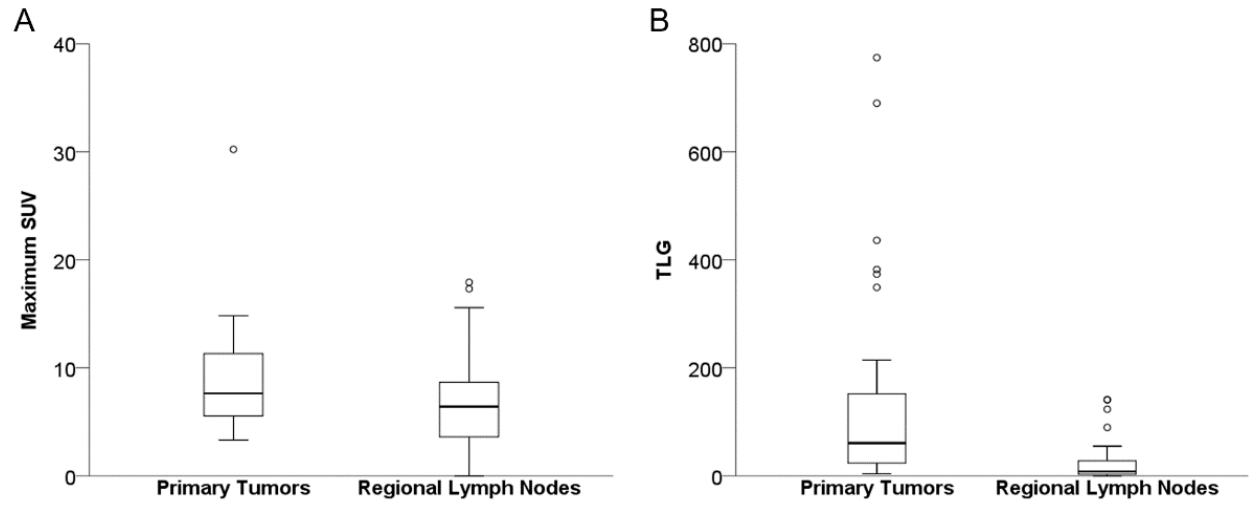
Figure 3. Box plot of 18 F-FDG uptake of primary tumors and regional lymph nodes. Panels show the maximum standardized uptake value (SUV) ( A ) and total lesion glycolysis (TLG) ( B ) of primary tumors and regional lymph nodes. Circle represents outliers.